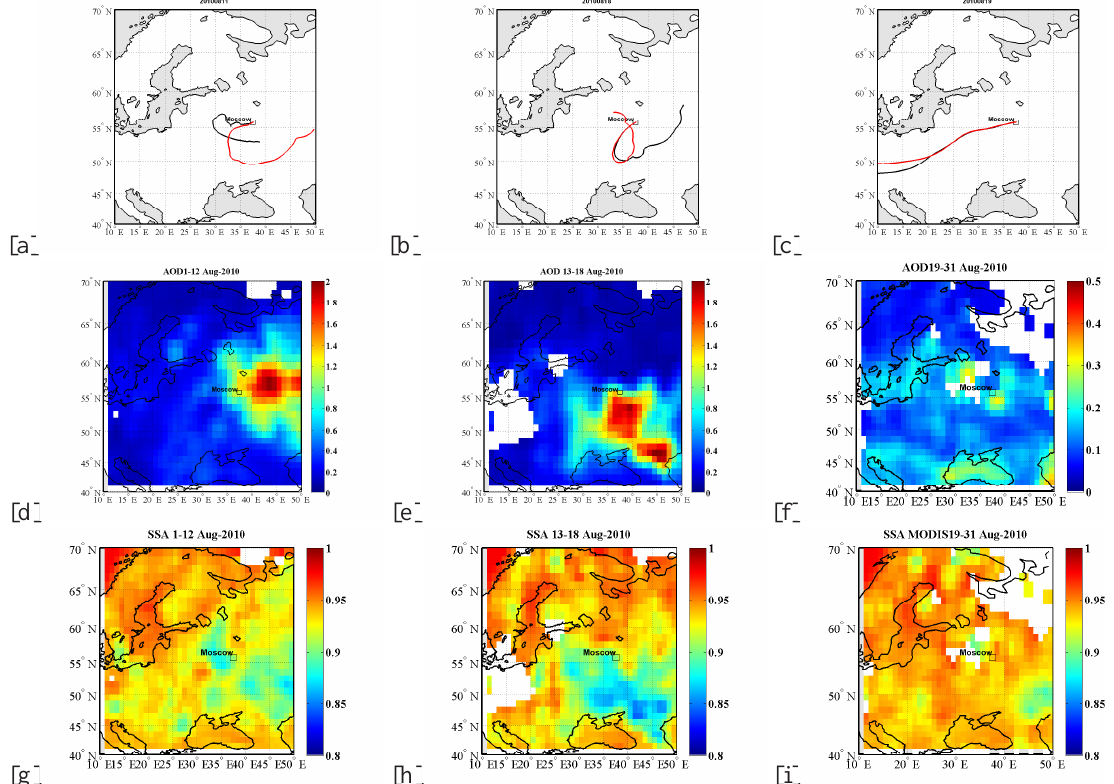
Figure 4. Air mass back trajectories, AOD and SSA over the study region. Top row: 5-day back trajectories at 500m (red) and 1000m (in black) for (a) 11 August, (b) for 18 August and (c) for 19 August. Middle row: spatial distributions of AOD at 0.555µm for three different periods in August 2010. Bottom row: spatial distributions of SSA at 0.555µm for the same